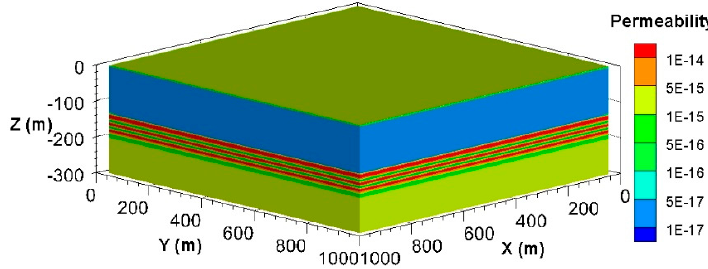
Figure 3. Permeability distribution of the layered heterogeneity model.